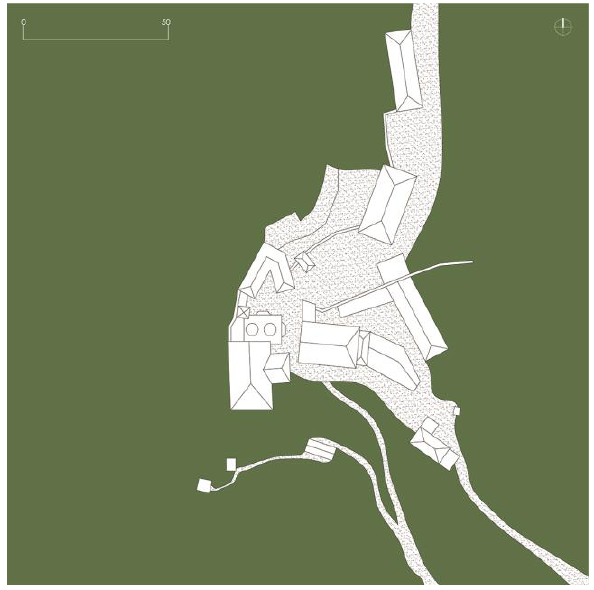
Figure 17 . The Monastery of Simonpetra. General plan.